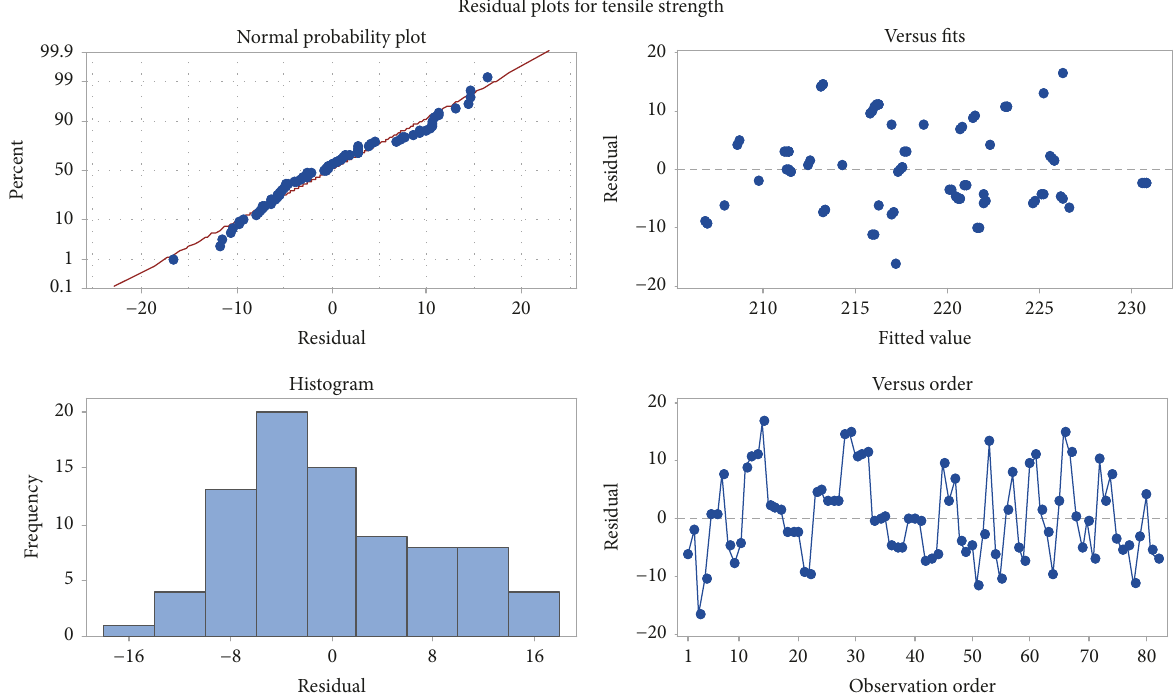
Figure 4: Residual plots of tensile strength using linear regression